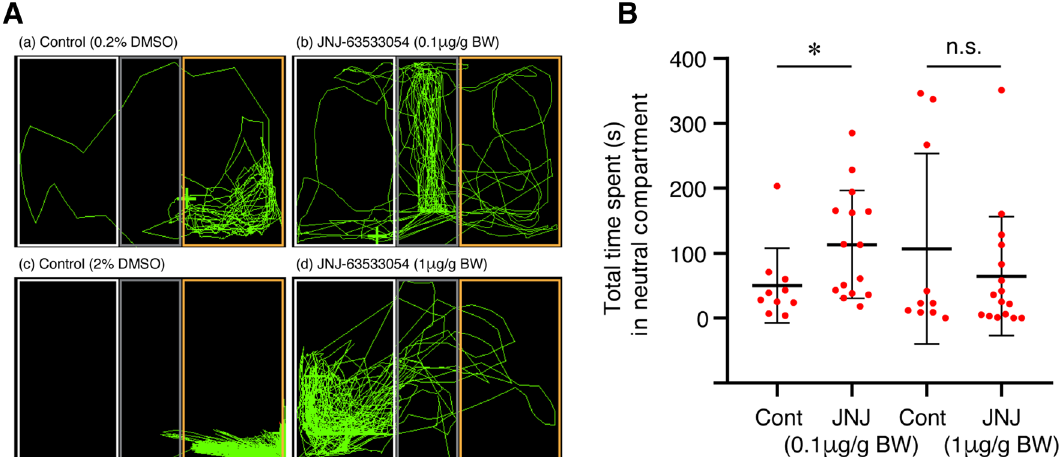
Figure 6. Effect of GPR139 agonist on preference to the neutral compartment during fear memory recall. ( A ) Representative top-view video tracking of swimming behaviour in controls ( a and c , 0.2% and 2% DMSO, respectively) and the fish treated with GPR139 agonist ( b and d , 0.1 and 1 µg/g BW of JNJ-63533054, respectively). ( B ) Total time spent in the neutral context (grey compartment) during post-conditioning in controls and GPR139 agonist-treated fish. The fish treated with 0.1 µg/g BW of GPR139 agonist spent a significantly ( P = 0.0477) longer time in the neutral compartment as compared to control. *, P < 0.05. n.s., no significant